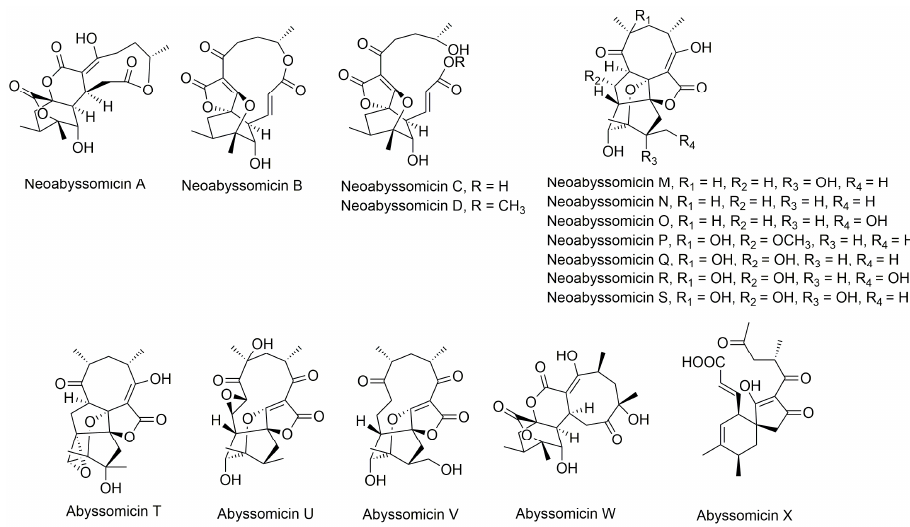
Figure 2. Structures of abyssomicins B–E, G–L, M–X, 2–5, atrop-abyssomicin C, ent-homoabyssomicin